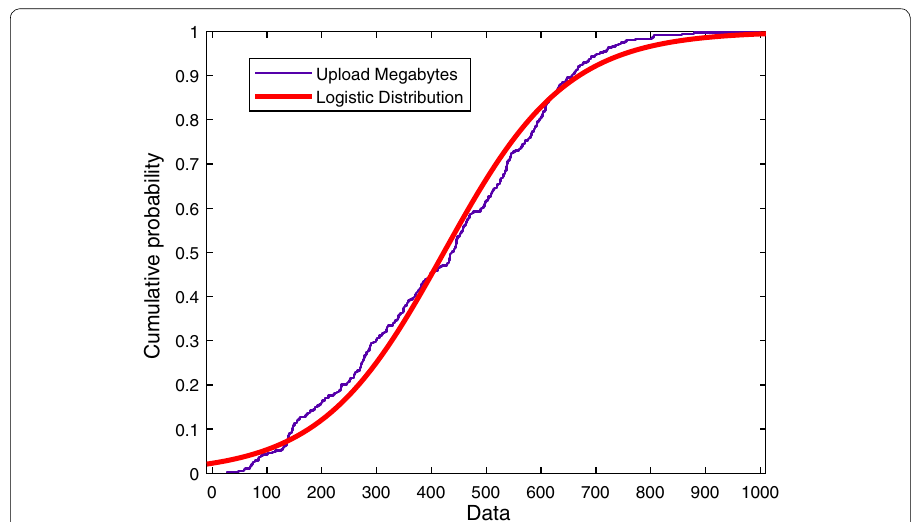
Fig. 9 Cumulative probability plot of the internet upload traffic